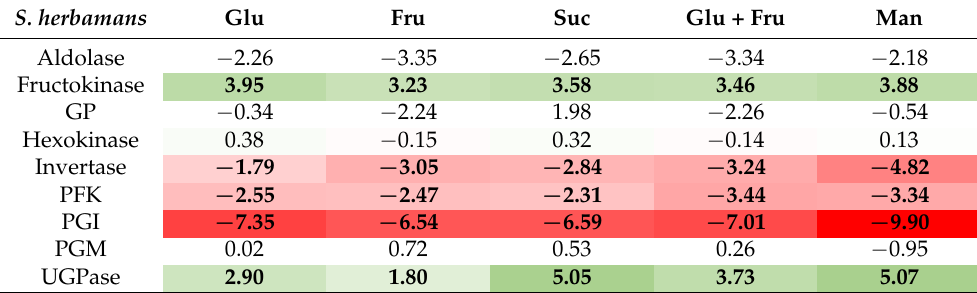
Table 3. Sugar regulation of enzyme activities in the cytosol of S. herbamans 14 days cultivated in the presence of glucose (Glu), fructose (Fru), sucrose (Suc), an equimolar mix of glucose and fructose (Glu + Fru), mannose (Man) or without sugar. The table shows the M-values (log2 of ratios of values obtained from sugar-treated cultures to values from cultures cultivated without sugar). Values higher than 1 (>2-fold induced) below − 1 (>2-fold repressed) and which are based on significant differences (Tukey HSD test; n = 6) are indicated in bold and color-coded (green: sugar induction; red: sugar repression). Activity of glucose-6-phosphate dehydrogenase was very low and not affected. S. herbamans Glu Fru Suc Glu + Fru Man Aldolase − 2.26 − 3.35 − 2.65 − 3.34 − 2.18 Fructokinase 3.95